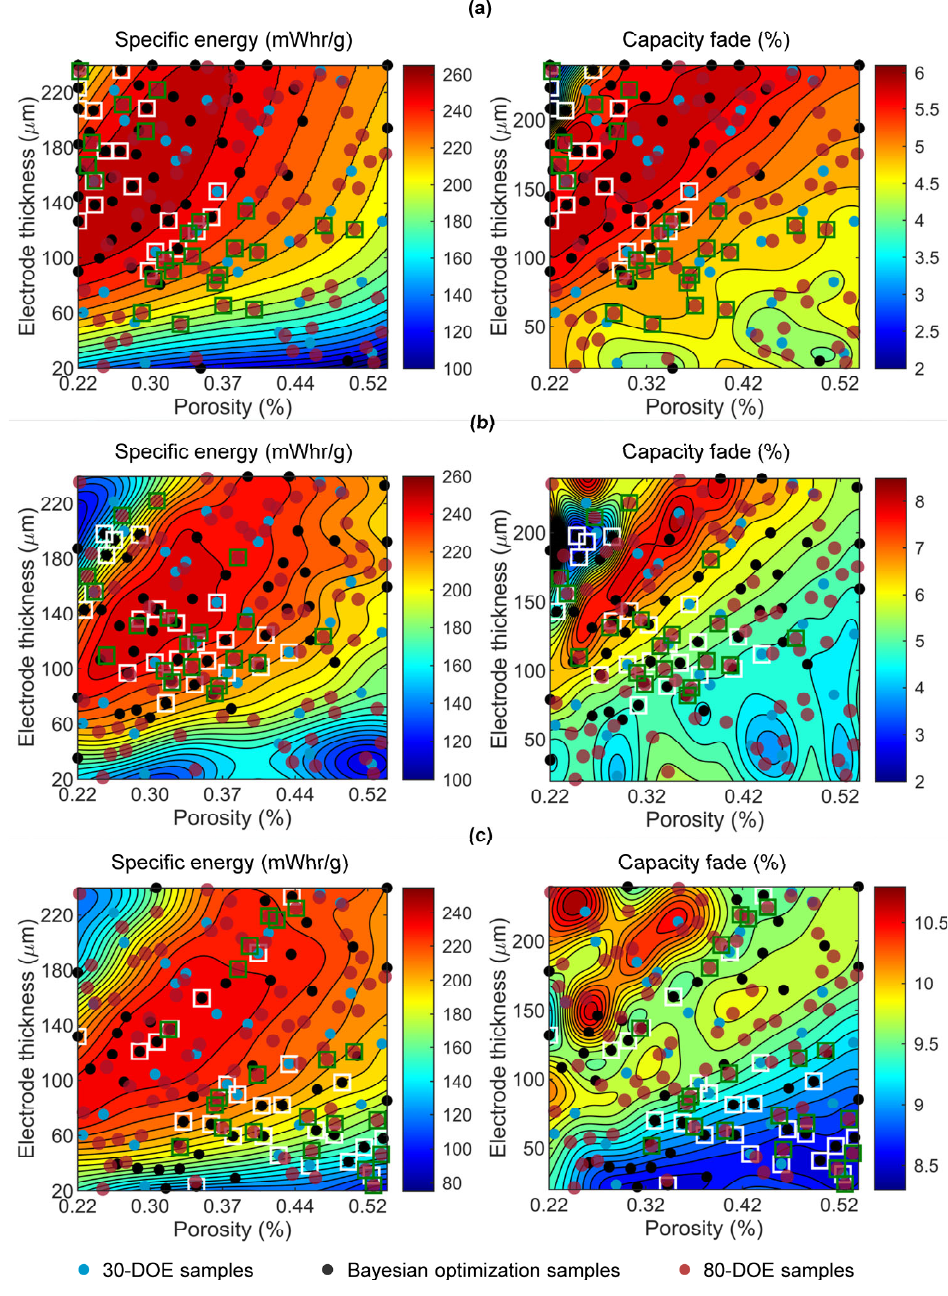
Figure 8. Gaussian process predictions of the specific energy and capacity fade for charge–discharge scenarios: ( a ) 0.1 C charge–0.1 C discharge; ( b ) 0.12 C charge–0.23 C discharge; ( c ) 0.23 C charge–0.23 C discharge. The blue dots are the initial 30 DOE samples, the black dots are the 50 Bayesian optimization samples, the red dots are the 80 DOE samples. The designs enclosed in white and green squares are the optimal designs from Bayesian optimization and the 80-sample DOE, respectively.